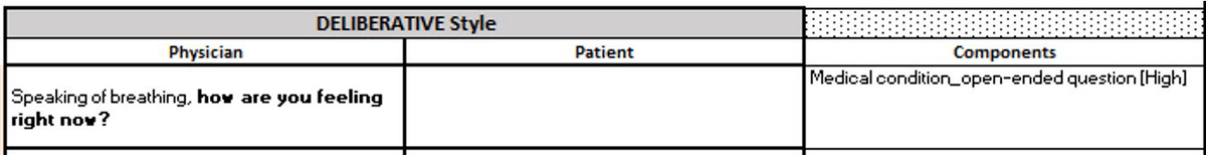
Figure 1. An example of the developed script for the deliberative version of the conversational agent (CA) Robo is shown here. The column labeled “Components” depicts the applied communication item and its respective communication frequency for the respective interaction style. The column labeled “Physician” describes what the CA Robo says, whereas the column “Patient” shows the reply options of the participant.